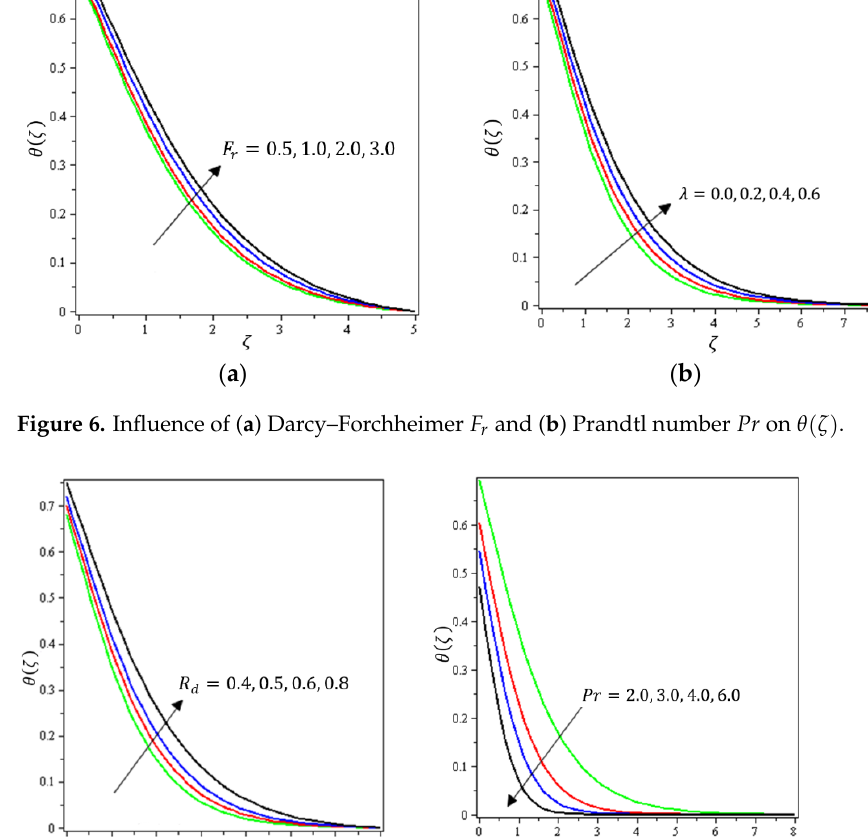
Figure 5. Influence of material parameter 𝛼 on velocities ( a ) 𝑓′(𝜁) and ( b ) g ′(𝜁) .